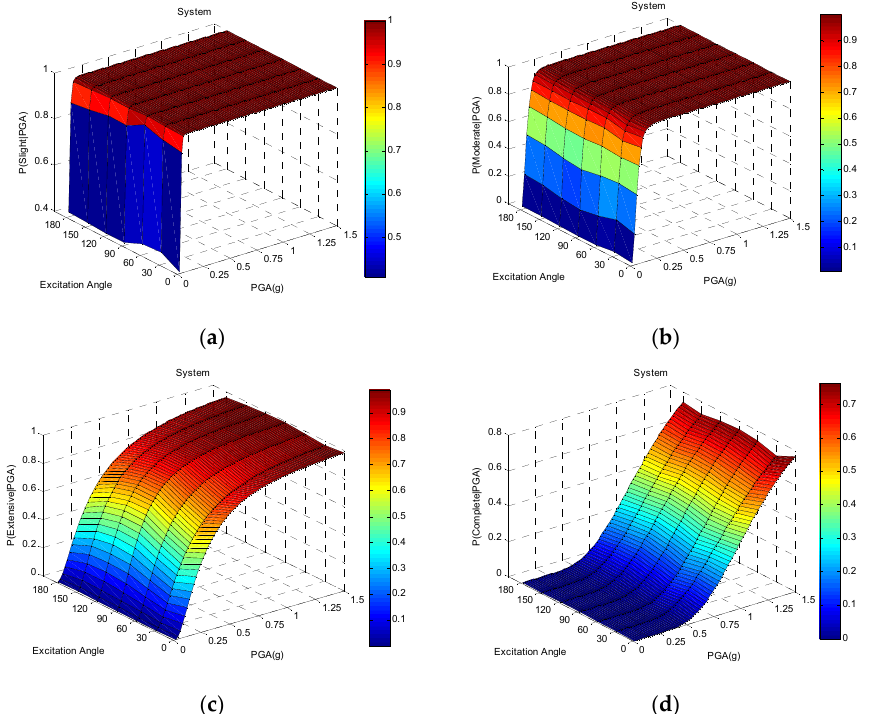
Figure A8. Seismic fragility surfaces of Absk subjected to different excitation angles in the ( a ) slight; ( b ) moderate; ( c ) extensive; and ( d ) complete limit states.